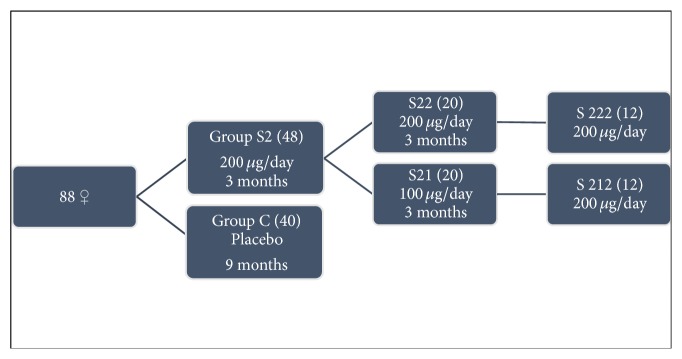
Adapted from [26].